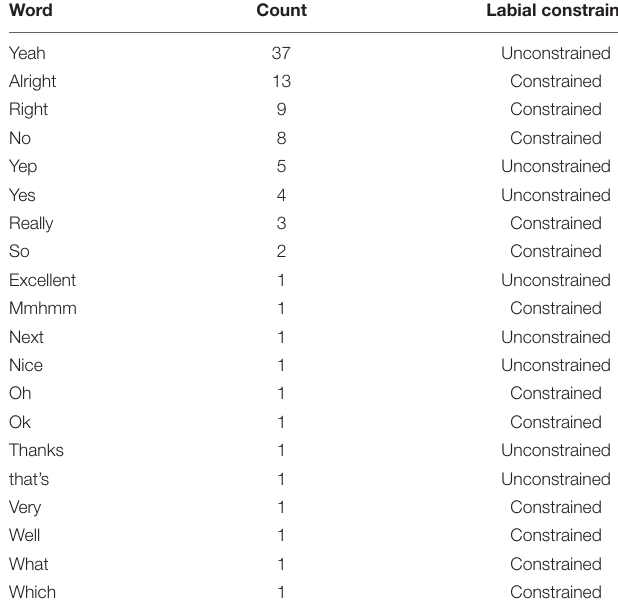
TABLE 3 | Content and frequency of 1-word